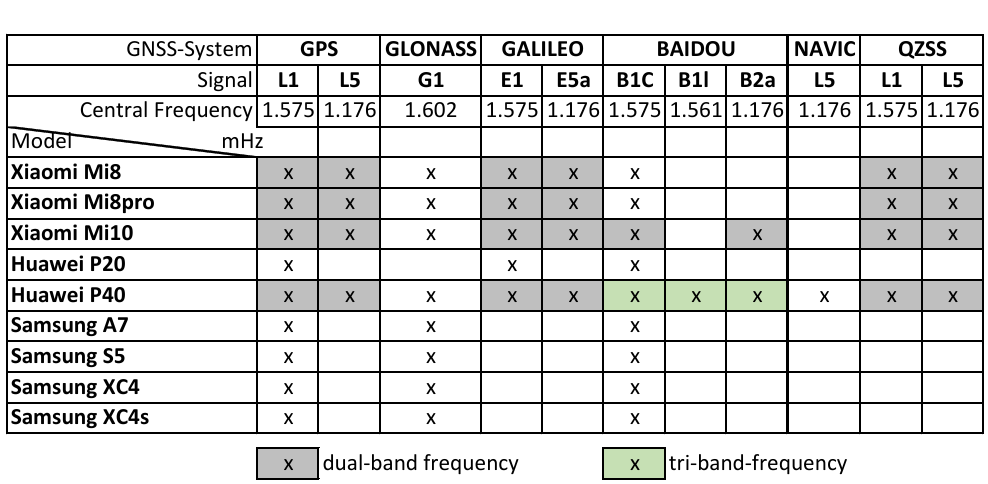
Figure 2. Overview of the different types of smartphones used and their ability to use the different GNSS constellations and